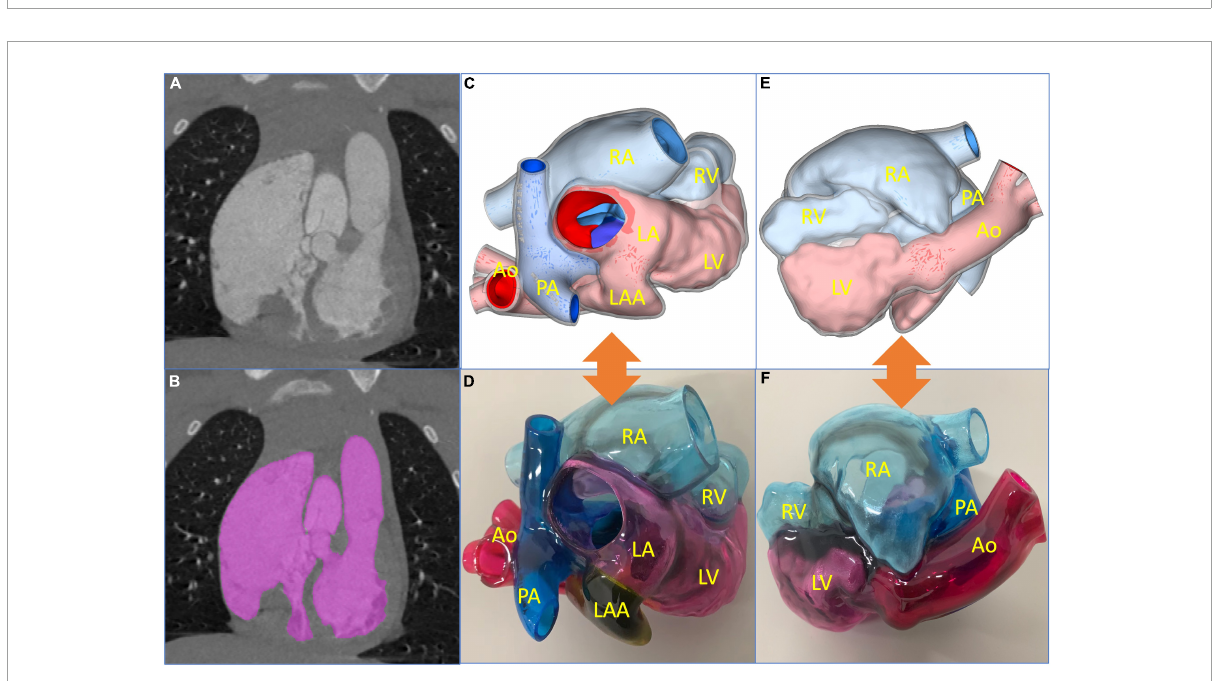
FIGURE2 Reconstructed process of three-dimensional (3D) printed model and preoperative evaluation. (A) Original computed tomography angiography data. (B) Edition of the mask. (C,D) The 3D reconstructed and printed models are shown in the front view, respectively. (E,F) The 3D reconstructed and printed models are shown in the rearview, respectively. In the 3D printed model, the red part is the aorta (Ao), the blue part is the pulmonary artery (PA), the yellow part is the left atrial appendage (LAA), the pink part is the left atrium (LA) and left ventricle (LV), and the light blue part is right atrium (RA) and right ventricle